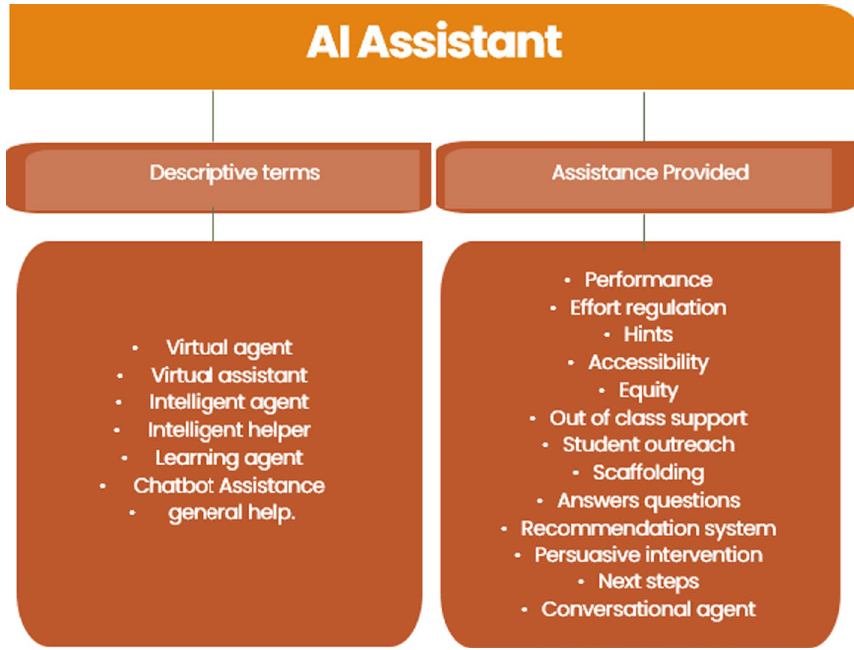
Fig. 10 AI assistant axial